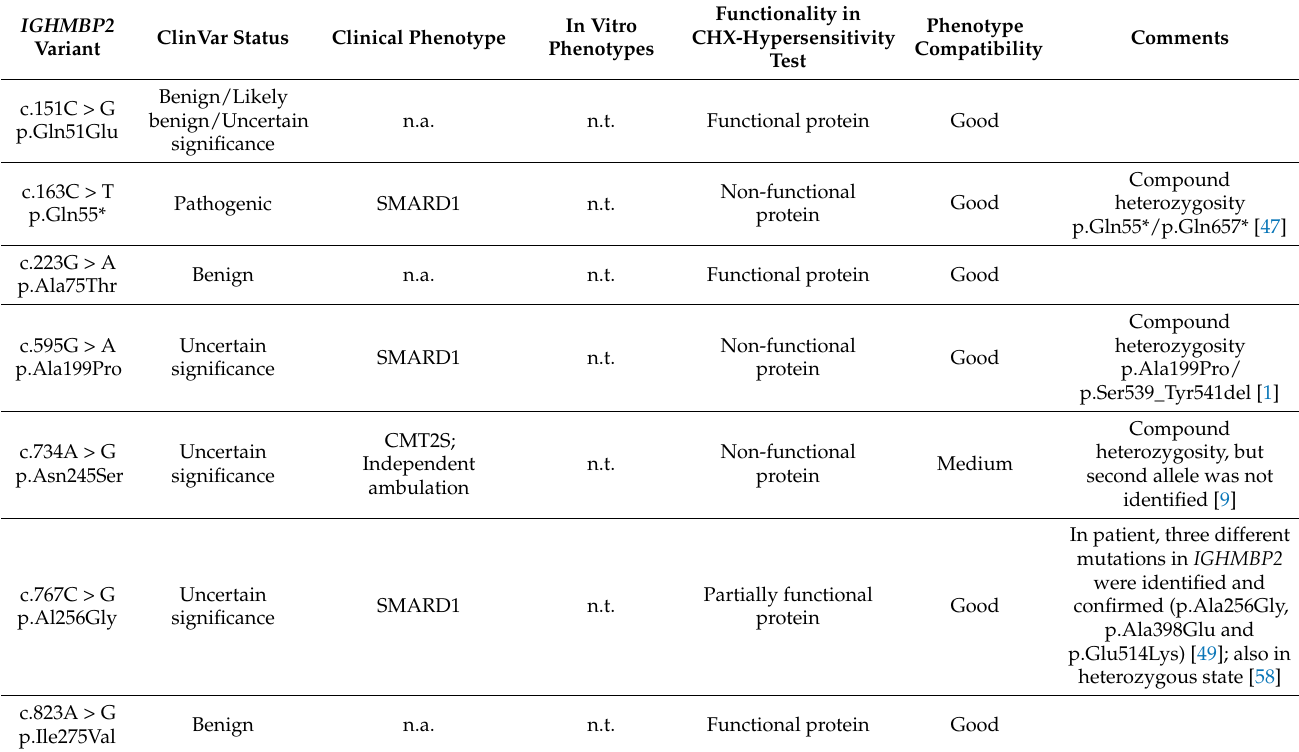
Table 1. Characteristics of tested